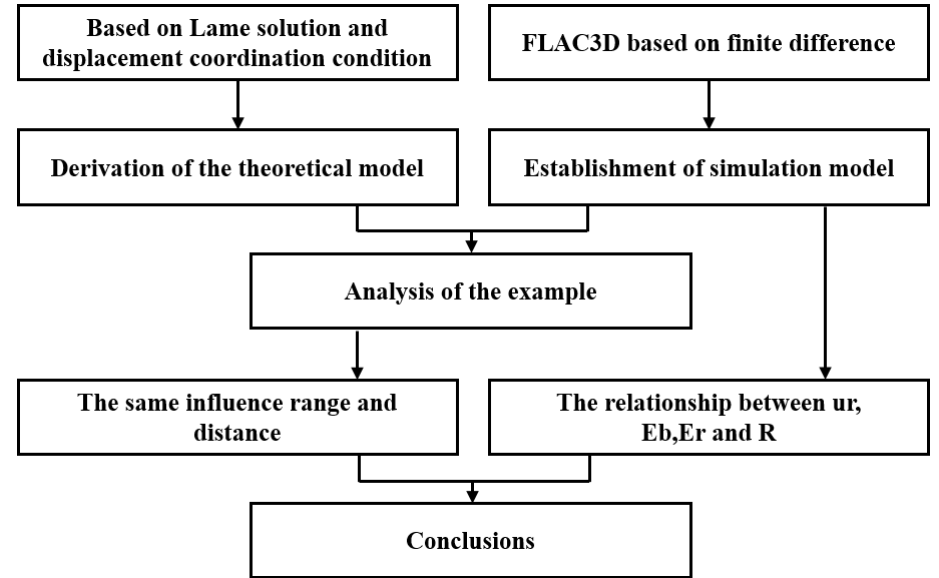
Figure 1. Analysis process.